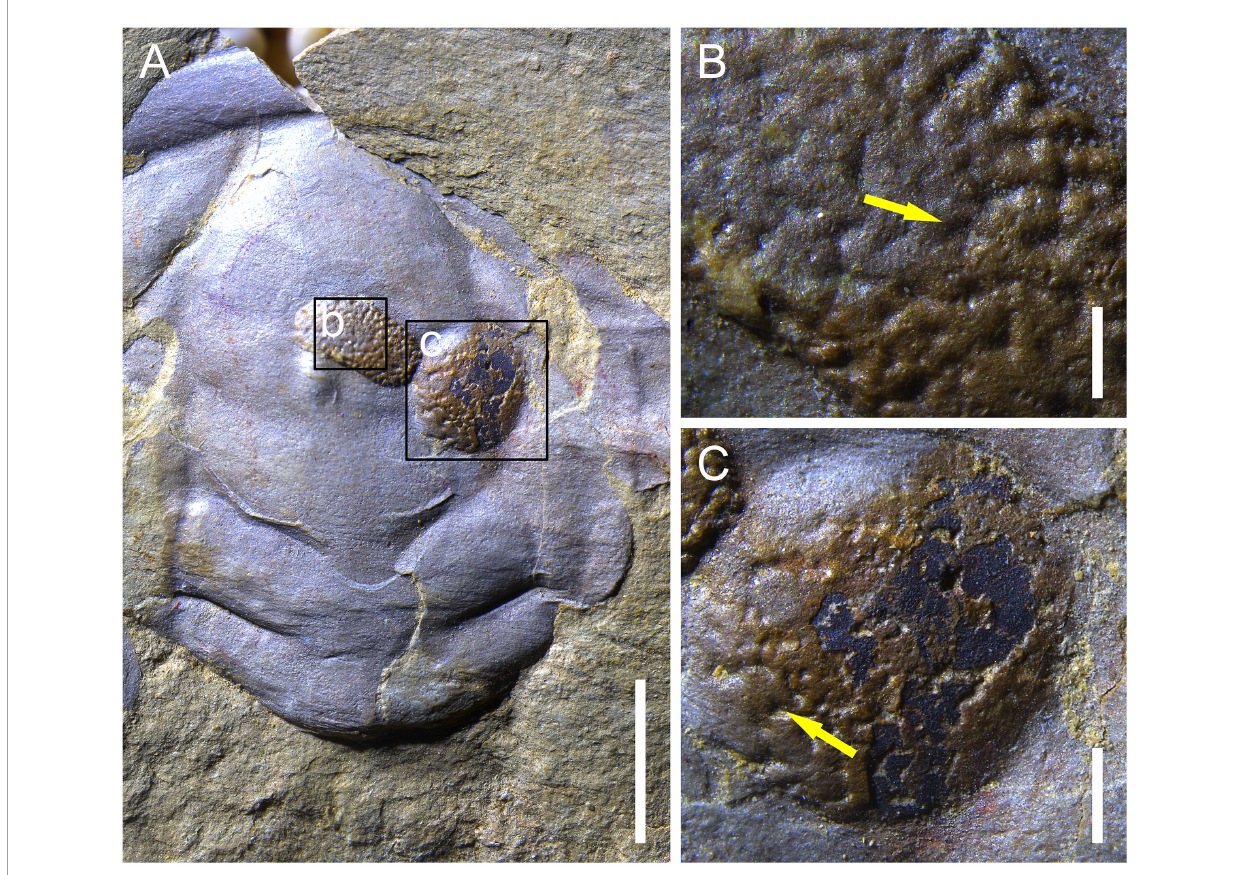
FIGURE3 The unnamed bryozoan-like metazoan (RCP-ZJ-0003-0004). (A) RCP-ZJ-0003-0004 are preserved on a trilobite glabella; (B) detail of RCP-ZJ-0003 [position marked by frame b in panel (A) ], yellow arrow indicates an opening of the specimen; (C) detail of RCP-ZJ-0004 [position marked by frame c in panel (A) ], yellow arrow indicates an opening of the specimen. The scale bars are 5 mm for panel (A) , 0.5 mm for panel (B) , and 1 mm for panel (C)